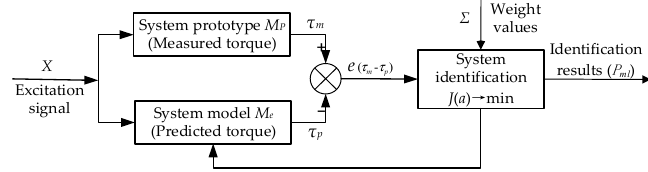
Figure 2. P ml identification schematic of weighted least squares (WLS).